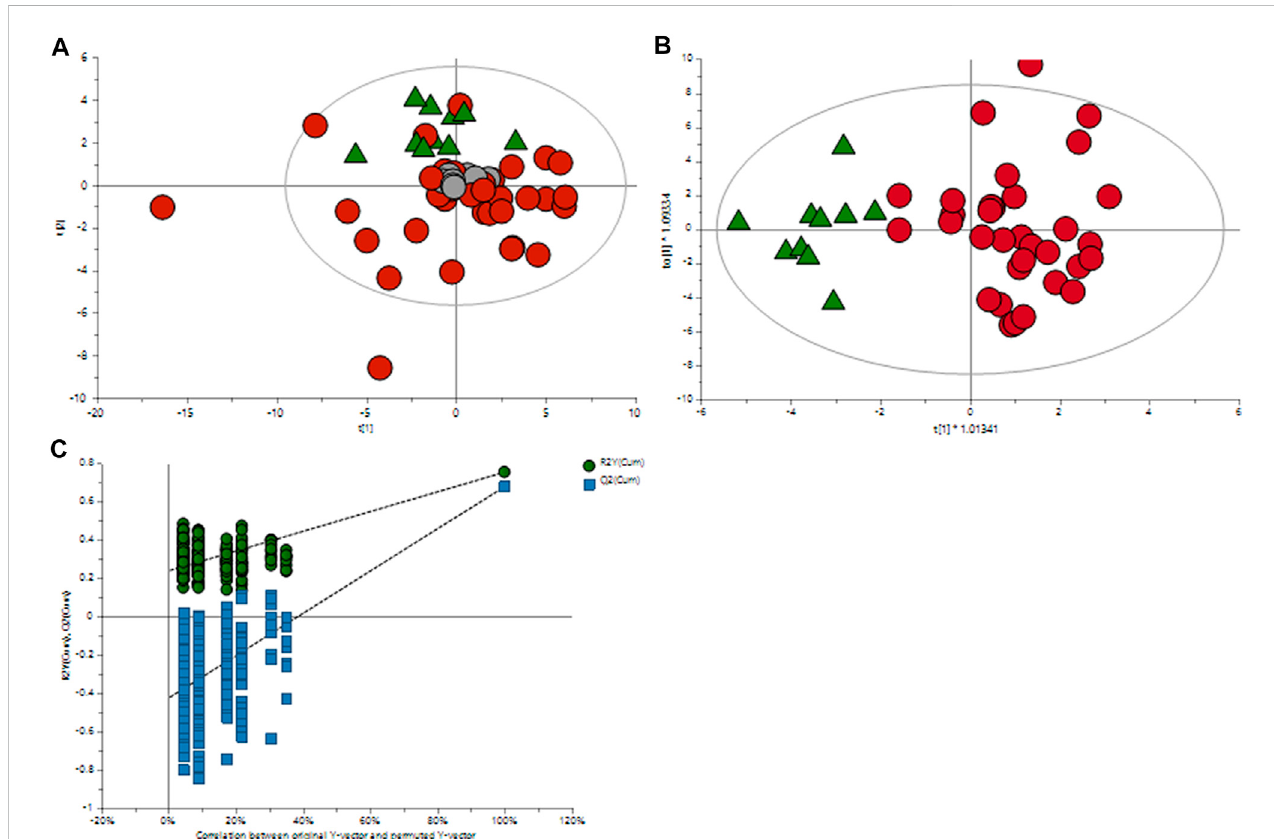
FIGURE 1 Multivariate OPLS-DA plots of plasma metabolomic pro fi les of GDM and NGT patients. (A) Principal component analysis (PCA) score plot of the metabolic pro fi le of the NGT and GDM groups after mean-centering and not (Ctr) scaling. (B) OPLS-DA score plot of the lipid pro fi le of the NGT and GDM groups after unit variance (UV) scaling. (C) Score plot of the OPLS-DA model obtained from (B) . The resulting R2 and Q2 values were plotted. The green dots representtheR2Yvaluesobtainedfromthedisplacementtest,thebluesquaredotsrepresenttheQ2valuesobtainedfromthedisplacementtest,andthe two dashed lines represent the regression lines of R2Y and Q,